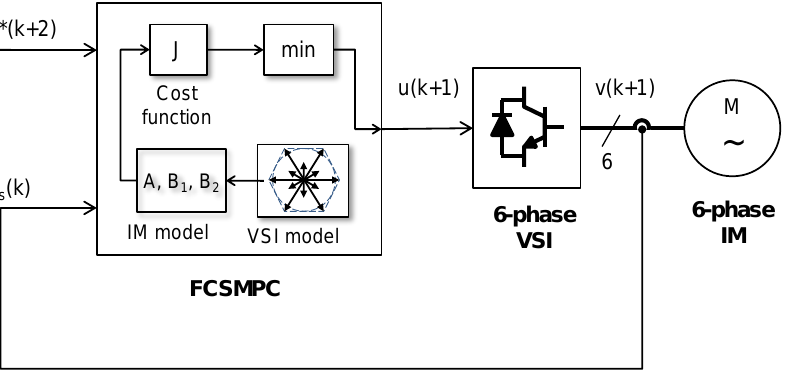
Figure 1. Diagram of FCSMPC of a six-phase